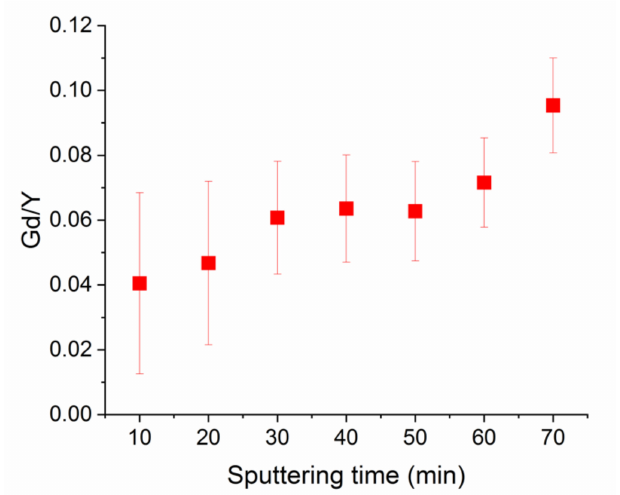
Figure 2. Depth profile for YBCO-Gd 5% film deposited by standard process. The error bars are provided for all the elements in the figure.